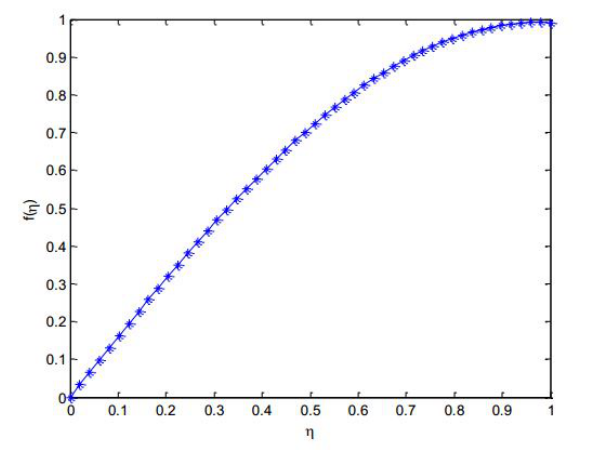
Figure 2. Figure 2a Variation of f ( η ) with the flow